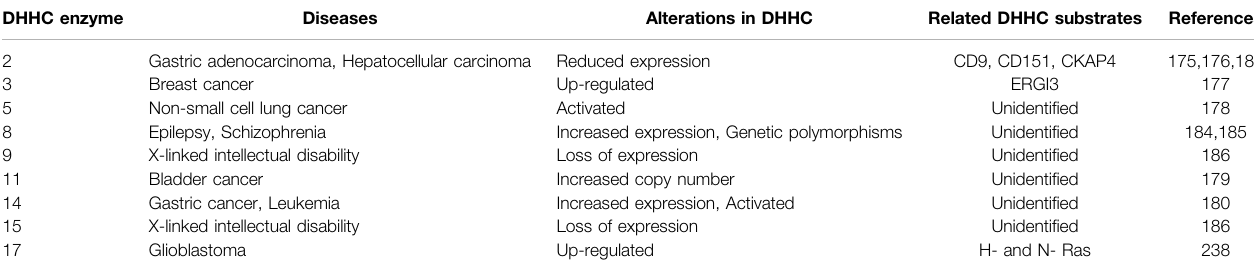
TABLE 2 | Summary of DHHC enzymes and human diseases. DHHC enzyme alterations in human diseases, including cancers and neurological diseases. DHHC